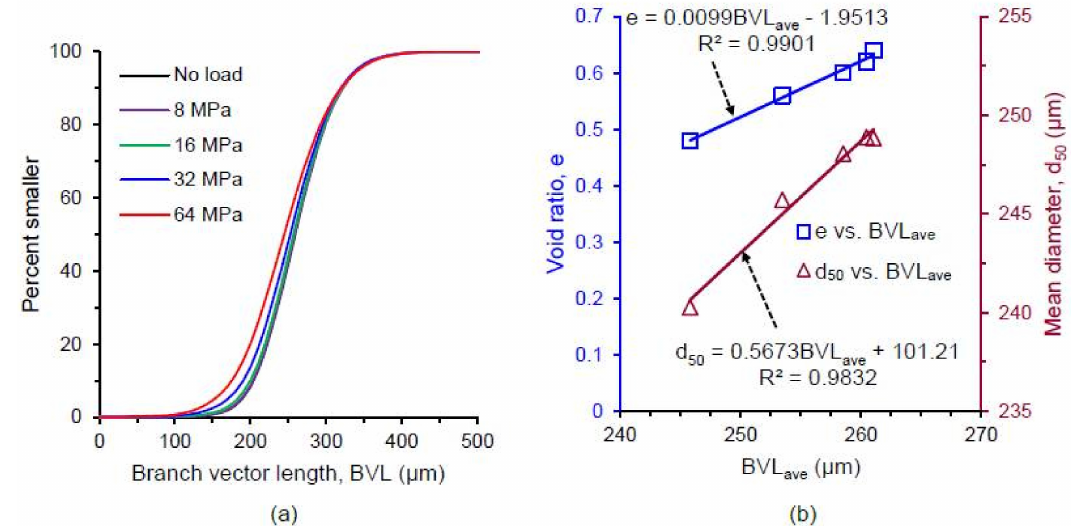
Figure 21. ( a ) Distributions of branch vector length of RBS particles at different vertical stresses; ( b ) Correlation between average branch vector length (BVLave), void ratio and mean diameter of RBS